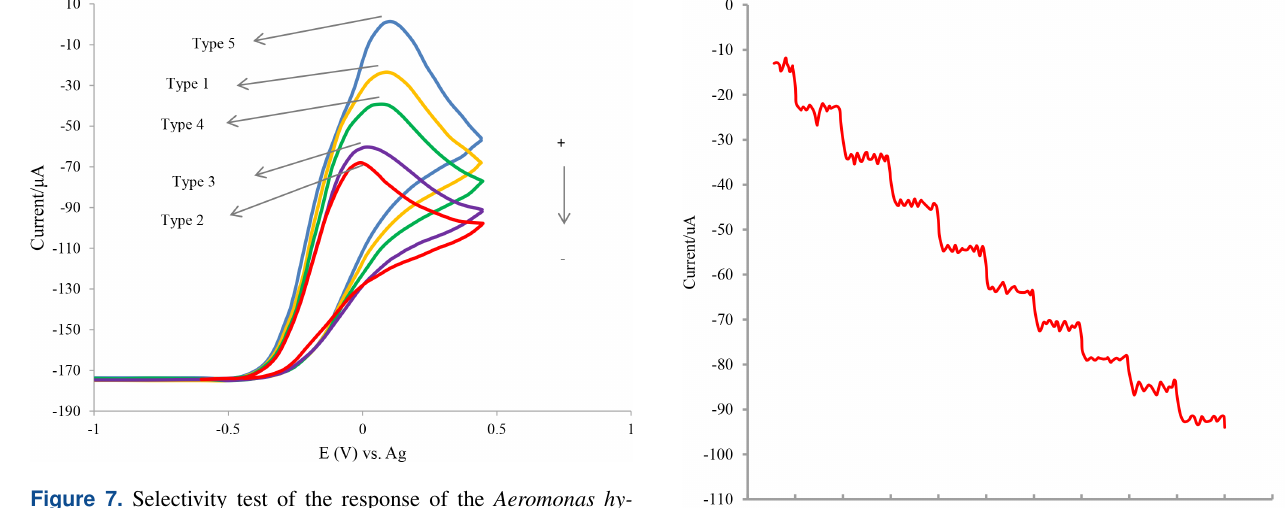
Figure 7. Selectivity test of the response of the Aeromonas hy- drophila DNA biosensor through various electrodes. Electrode type 2: existence of ZnS nanospheres, pssDNA, and tssDNA; electrode type 3: existence of pssDNA and tssDNA; electrode type 4: exis- tence of ZnS nanospheres and tssDNA; electrode type 1: existence of ZnS nanospheres and pssDNA; electrode type 5: existence of tss- DNA.